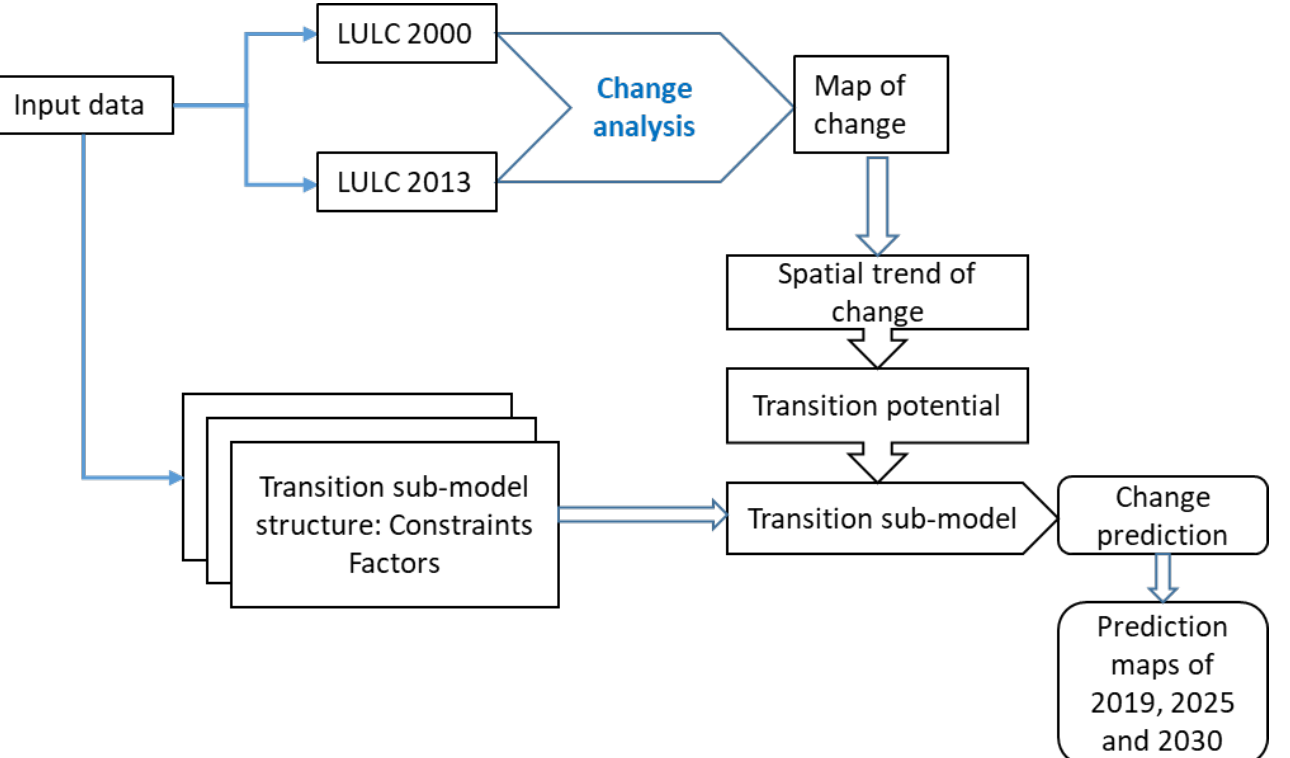
Figure 2. Land cover modeling using the Land Change Modeler (LCM). (LULC: land use land cover. Source: [67]).